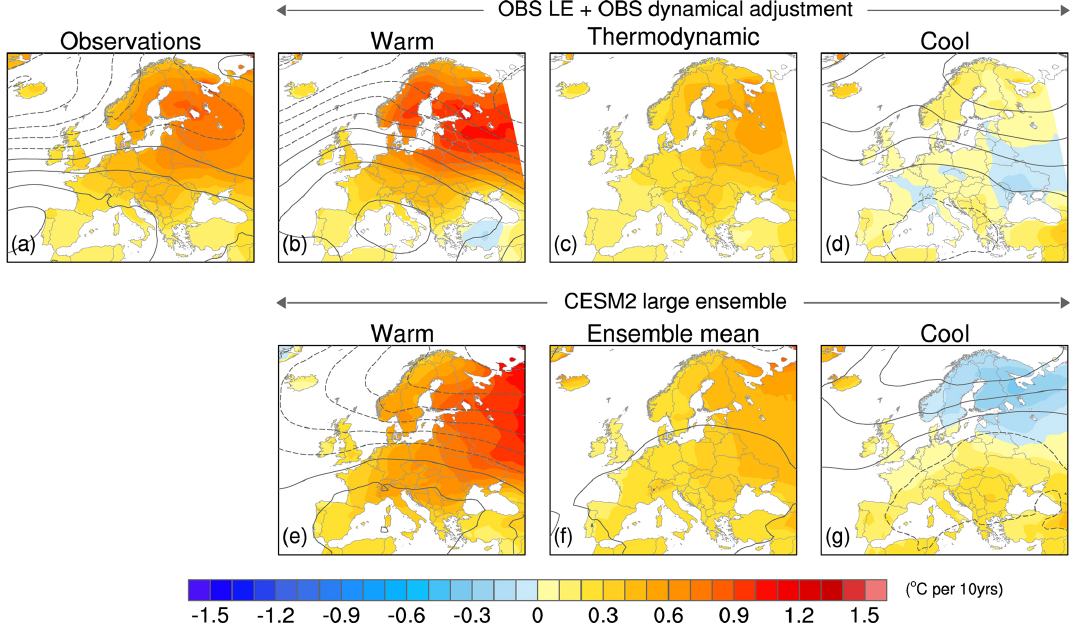
Figure 14. As in Fig. 10 but for the period 1962–2021. The top row (a–d) is based on the observational large ensemble combined with the residual thermodynamic component of observed trends. The bottom row (e–g) is based on the 100-member CESM2 large ensemble. See text for details.